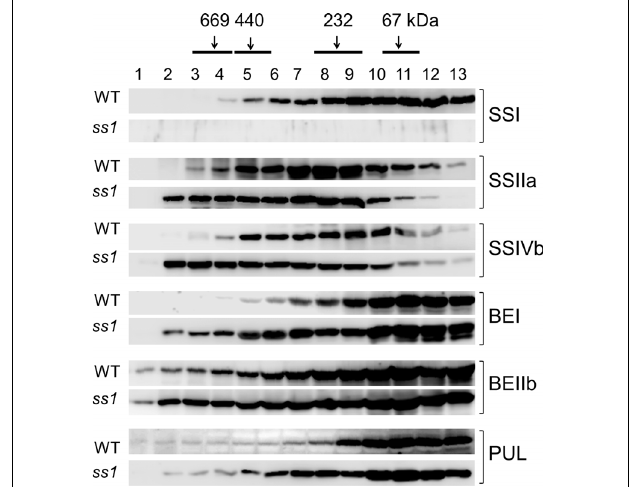
FIGURE 2 | Altered molecular weight distributions of starch biosynthetic enzymes in the ss1 mutant and its parental line, Nip (WT). Fractions 1–13 obtained after gel filtration chromatography of soluble proteins extracted from the developing seeds were analyzed by western blotting with specific antibodies. Top, numbers (kDa) indicate molecular weight standards. The images are representative of